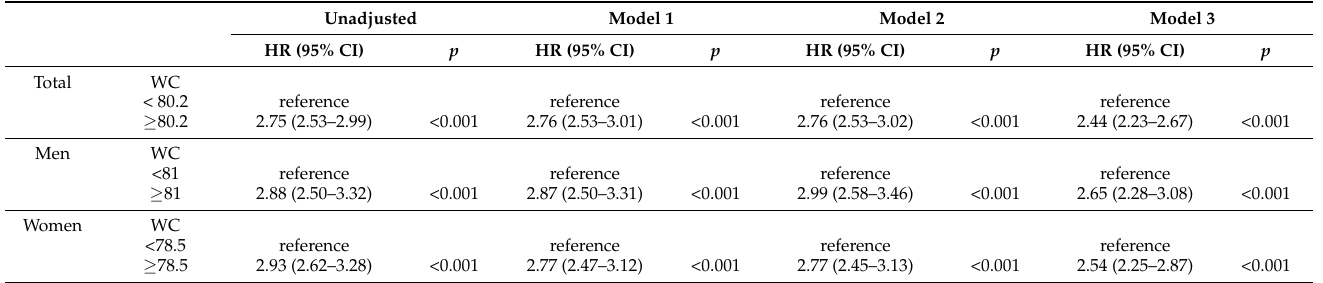
Table 3. Cox regression analysis for incidence of non–alcoholic fatty liver diseases according to the optimal waist circumference values by sex.